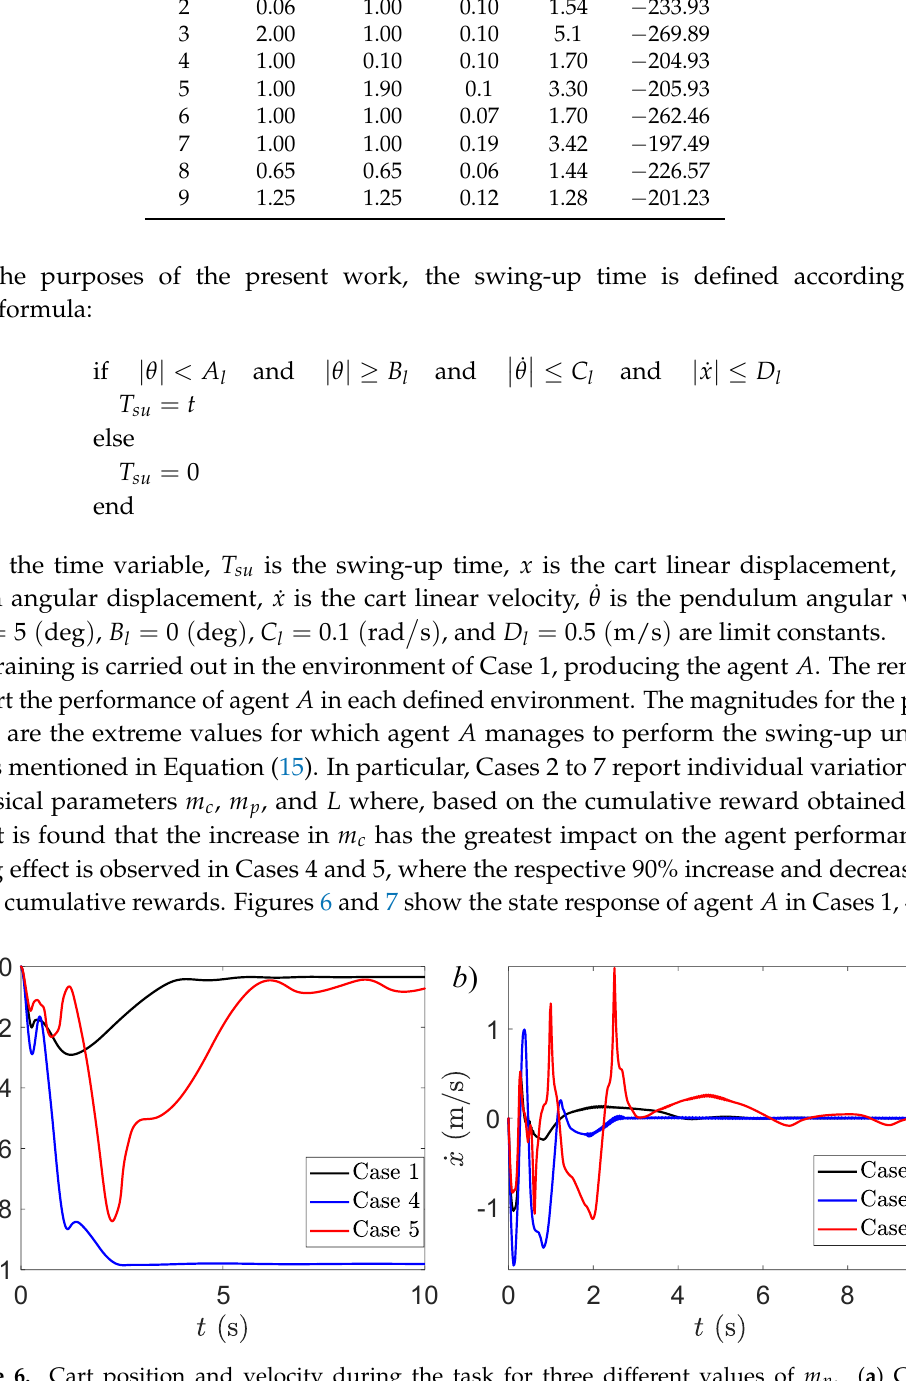
Figure 6. Cart position and velocity during the task for three different values of m p . ( a ) Cart displacement during the swing-up task. ( b ) Cart velocity during the swing-up